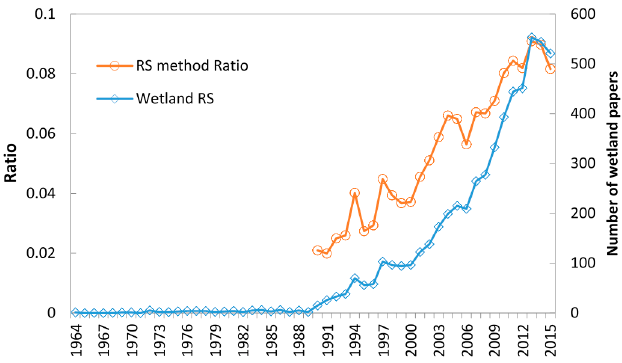
Figure 1. Number of wetland remote sensing publications and the ratio of wetland remote sensing to wetland research from 1964 to 2015.